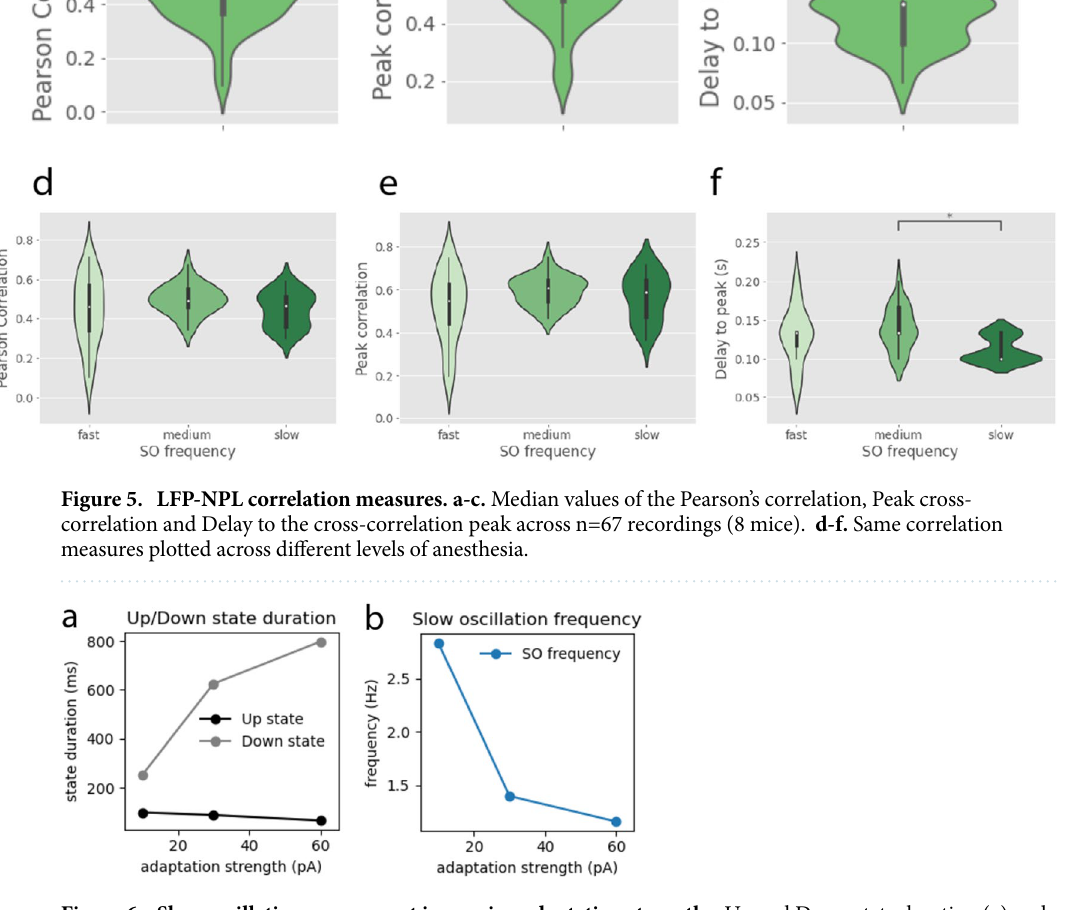
Figure 6. Slow oscillation measures at increasing adaptation strengths: Up and Down state duration ( a ) and frequency of the slow oscillation ( b ) at increasing adaptation strenght (parameter b in the